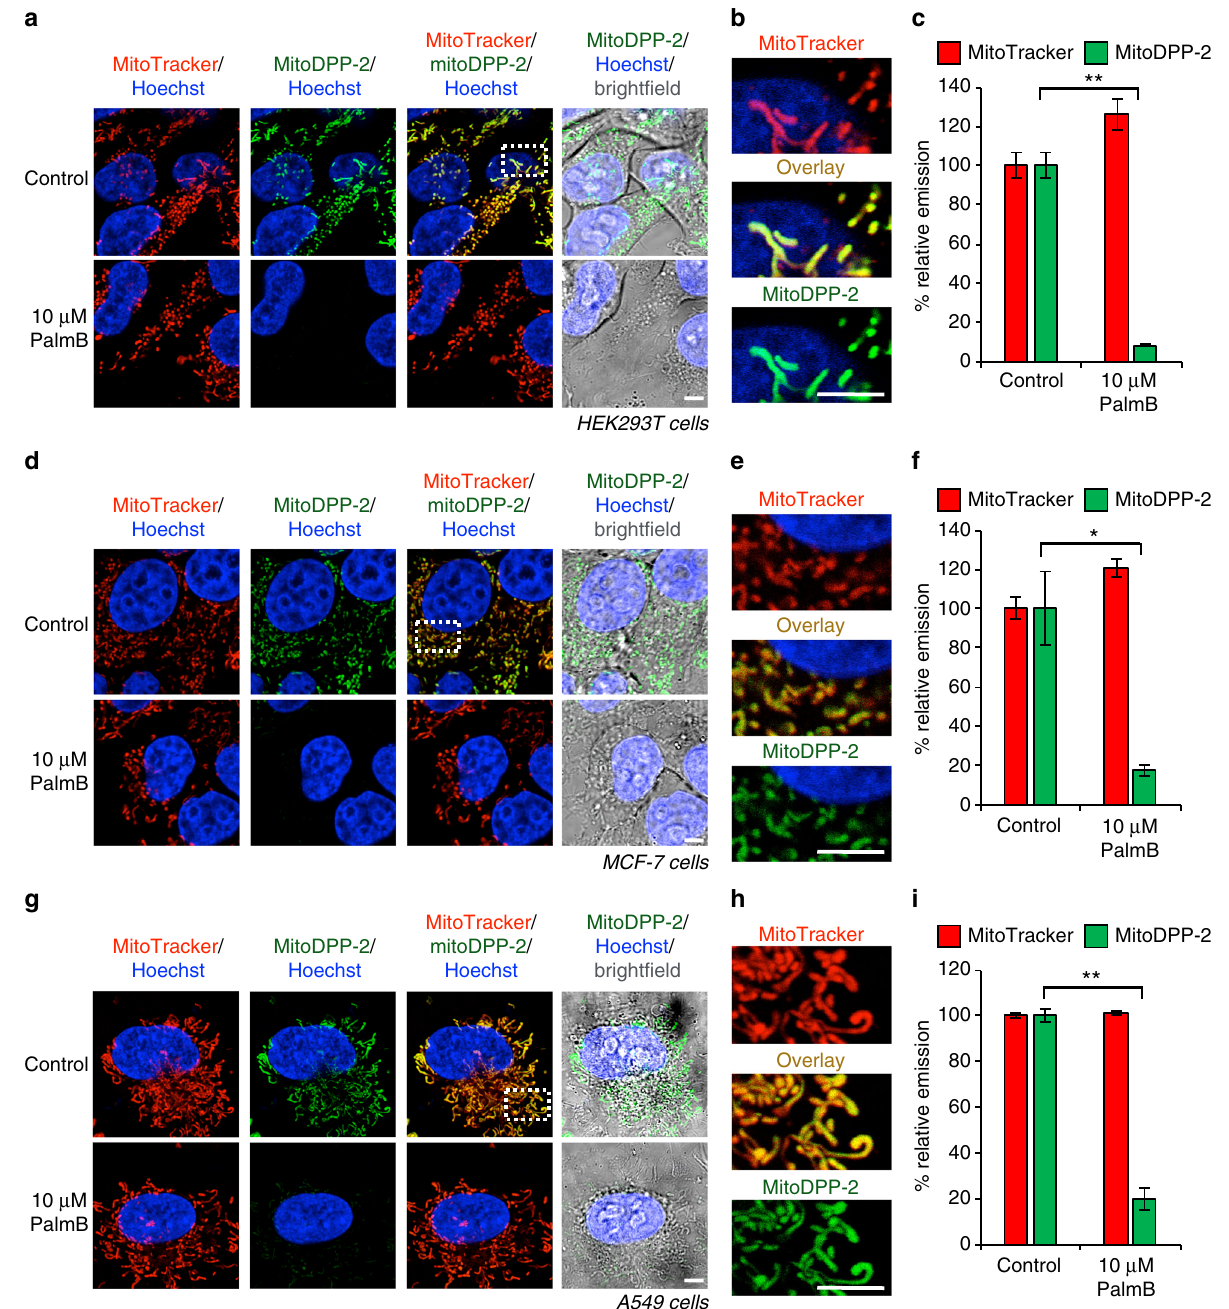
Fig. 3 Localization and PalmB inhibition of mitoDPP-2 in multiple cell lines. a HEK293T cells treated for 30 min with 1 µ M Hoechst 33342, 100 nM MitoTracker Deep Red, and either DMSO or 10 µ M PalmB, washed, loaded with 250 nM mitoDPP-2 for 10 min, and then analyzed by confocal fl uorescence microscopy. b Enlarged portion of image indicated by dotted white line in ( a ) showing colocalization of mitoDPP-2 with MitoTracker. c Quanti fi cation of the relative fl uorescence intensity from mitoDPP-2 and MitoTracker in either control or PalmB-treated cells from ( a ). d MCF-7 cells treated and analyzed identically to conditions in ( a ). e Enlarged portion of image indicated by dotted white line in ( d ). f Quanti fi cation of the relative fl uorescence intensity from mitoDPP-2 and MitoTracker in either control or PalmB-treated cells from ( d ). g A549 cells treated and analyzed identically to conditions in ( a ). h Enlarged portion of image indicated by dotted white line in ( g ). i Quanti fi cation of the relative fl uorescence intensity from mitoDPP-2 and MitoTracker in either control or PalmB-treated cells from ( g ). For all imaging, 5 µ m scale bar shown. For all plots, statistical analyses performed with a two-tailed Student ′ s t -test with unequal variance, * P value < 0.05; ** P value < 0.005, n = 3, error bars are ±